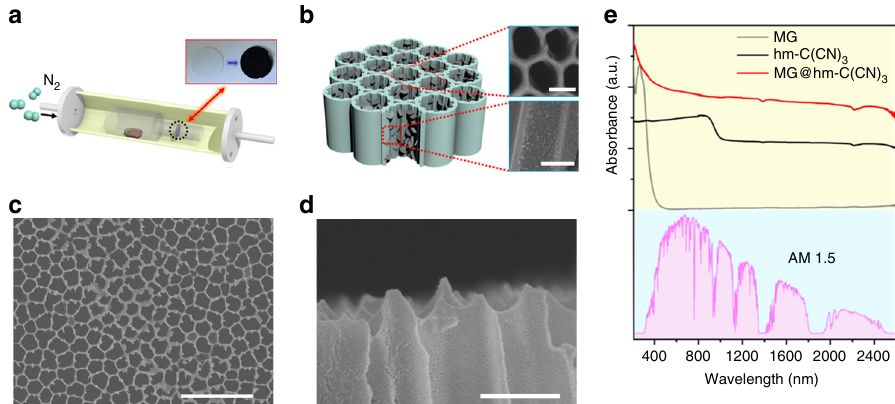
Fig. 3 Micro grid mode resonance based arti fi cial microstructure. a Schematic key steps involved in MG@hm-C(CN) 3 synthesis. Inset: digital camera images of a bare nanoporous template (white) sample and a MG@hm-C(CN) 3 sample (black). b Self-assembly of MG@hm-C(CN) 3 nanosheets on nanoporous templates to form arti fi cial microstructure (Scale bar, 150 nm). c Top-view (Scale bar, 1 μ m) and d cross-sectional (Scale bar, 200 nm) SEM images of the MG@hm-C(CN) 3 . e Experimental absorption spectra measured by an integrated sphere in the visible and near-infrared range. MG represents the sample of nanoporous anodic aluminum oxide membrane (AAM), hm-C(CN) 3 represents the sample of hm-C(CN) 3 bulk material, MG@hm-C(CN) 3 represents the sample of hm-C(CN) 3 nanosheets incorporated into AAM,